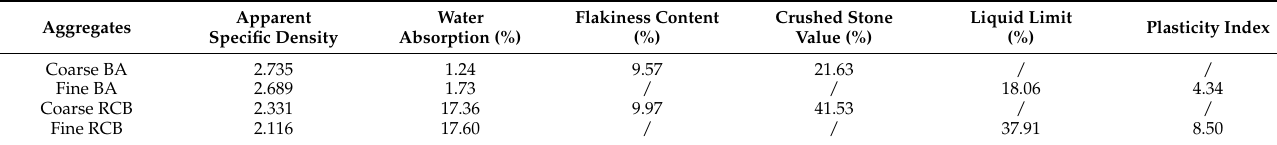
Table 1. The technical indicators of BA and RCB